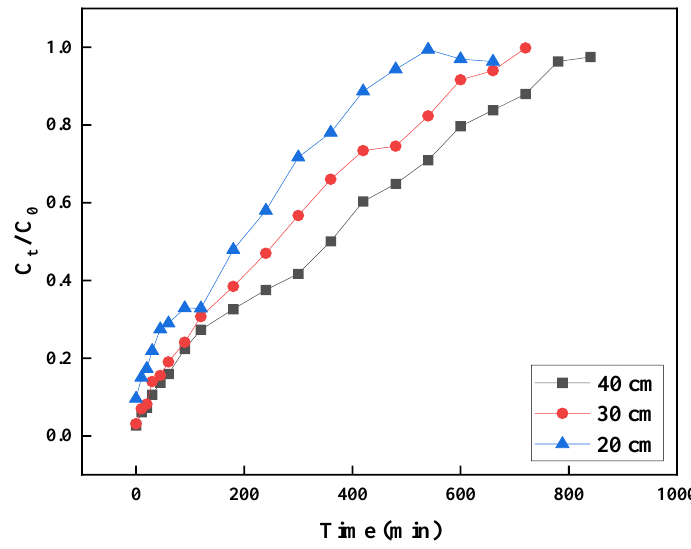
Figure 9. The effect of bed height on the adsorption of sulfate by WS60 in a fixed-bed column. Flow rate, 2 mL/min; pH 5.2 (0.03 M sodium acetate buffer); inlet sulfate concentration, 1100 mg/L.